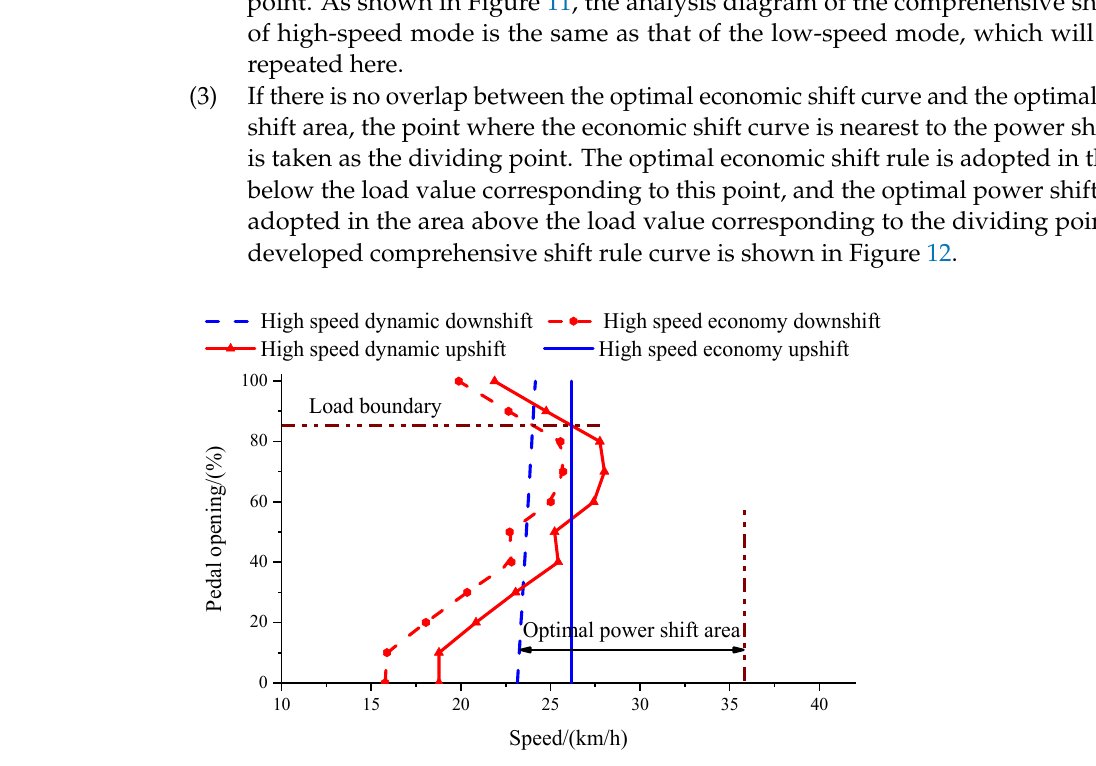
Figure 11. The comprehensive shift rule.